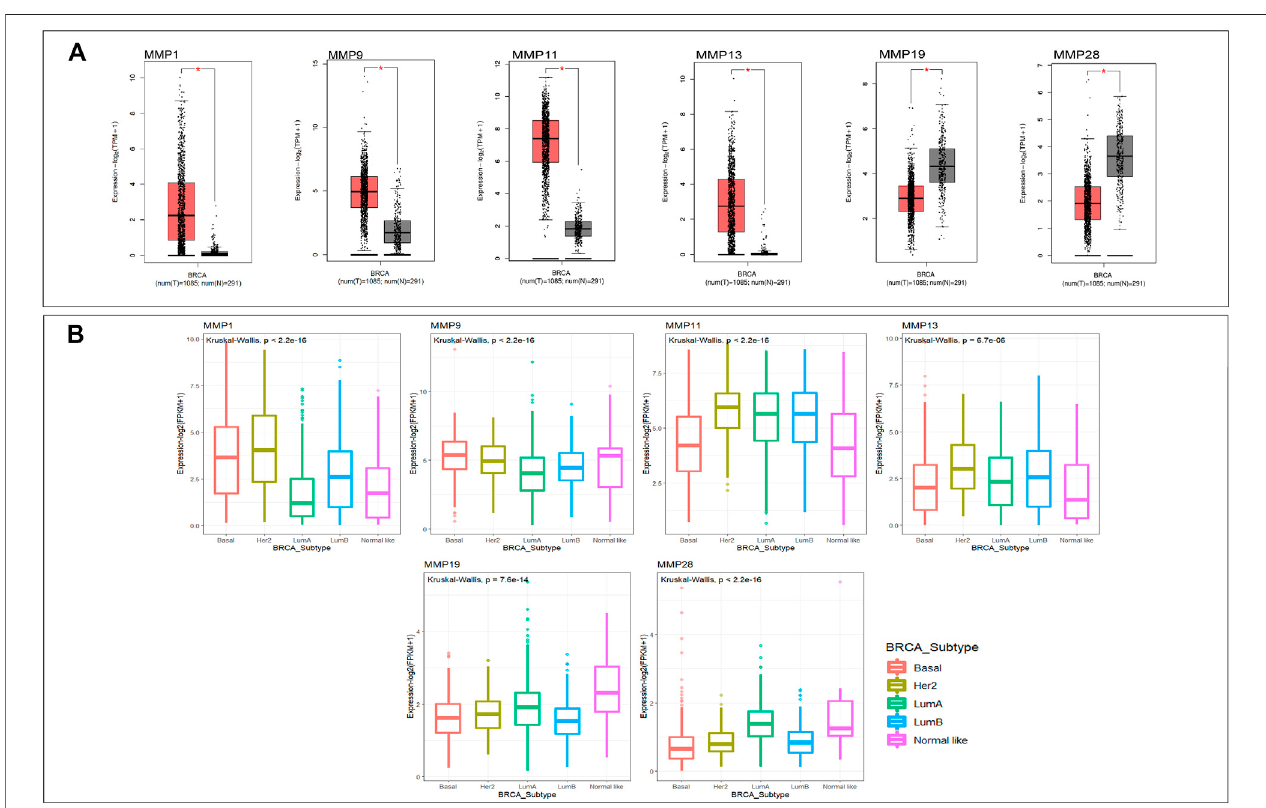
FIGURE 1 | (A) The mRNA expression of MMPs in breast cancer and normal breast tissue (GEPIA). The expression levels of MMP1, MMP9, MMP11, and MMP13 werehigher in breast cancer tissues than in normal tissues, and theexpression levels ofMMP19 and MMP28 were lower in the former than the latter ( p value < 0.05). (B) ThemRNAexpressionofMMPsin fi vesubtypesofbreastcancer( p value < 0.05).TheexpressionlevelsofMMP1,MMP9,MMP11,andMMP13inHer2subtypewerethe highest. The expression levels of MMP19 and MMP28 in Basal and LumB subtype were lower than that in